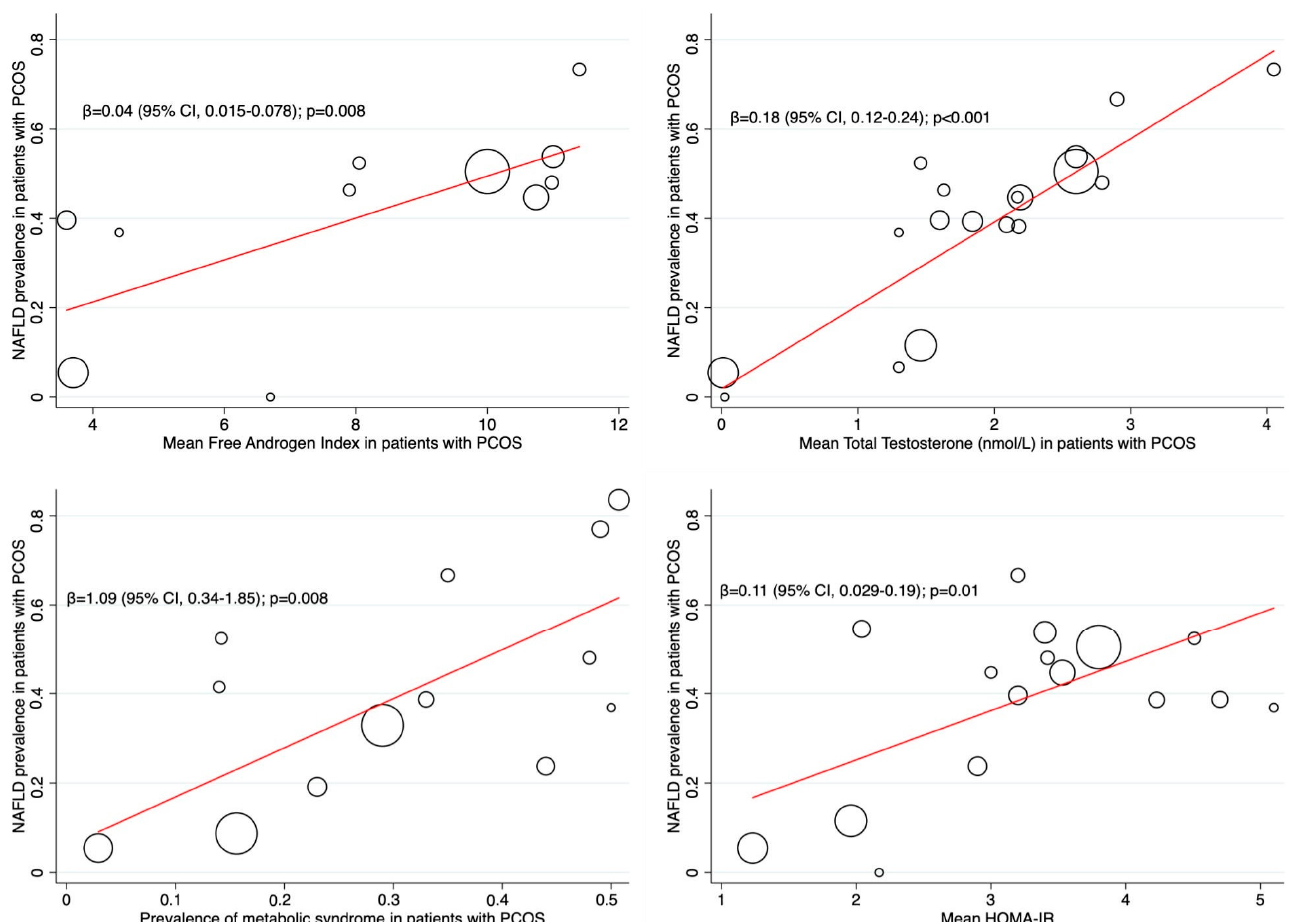
Figure 3. Metaregression